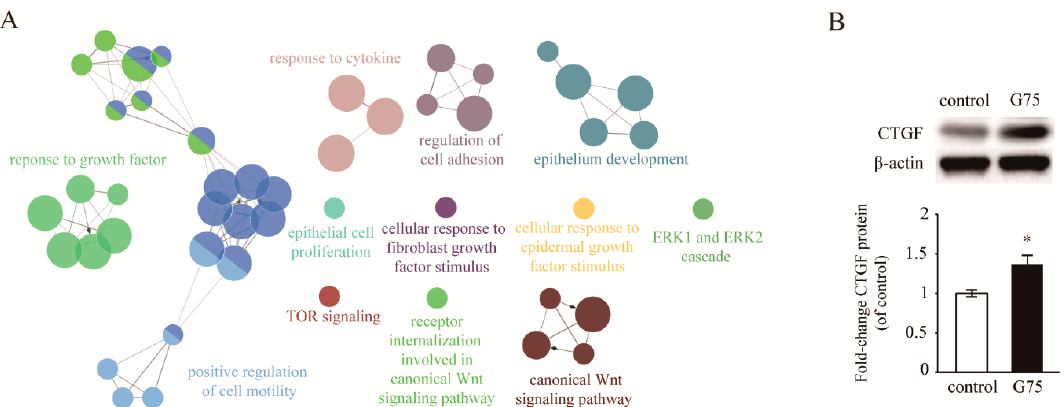
Figure 4. Effects of G75 on the biological pathways involved in wound healing. ( A ) Significantly activated biological processes on day three of G75 treatment based on the enriched GO clusters visualized by ClueGO are shown. To reduce redundancy of GO terms, fusion option was selected. For the functionally grouped networks with terms as nodes, the size of nodes represents the term enrichment significance linked with edge size based on their kappa score level ( ≥ 0.4), in which only the label of the most significant term per group is shown. ( B ) CTGF expression was increased by G75. Representative western blot analysis of CTGF expression in skin tissues collected from G75-treated mice three days after wounding. The results are presented as means ± S.E.M ( n = 3). * p < 0.05, two-tailed Student’s t -test.